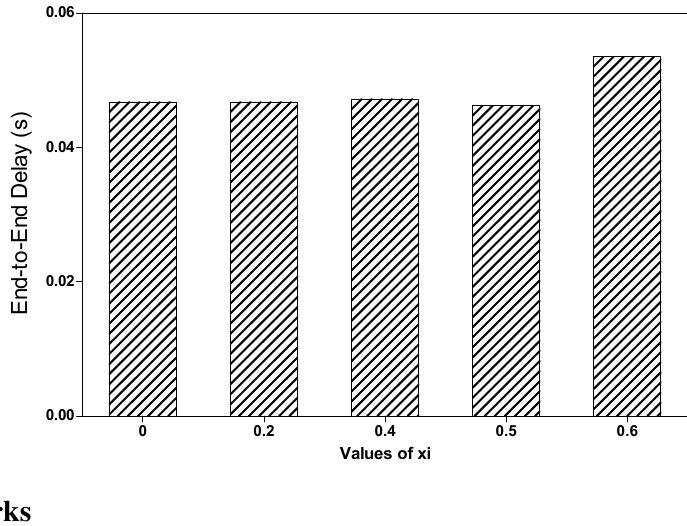
Figure 16. Effects of value of ξ on average end-to-end delay of